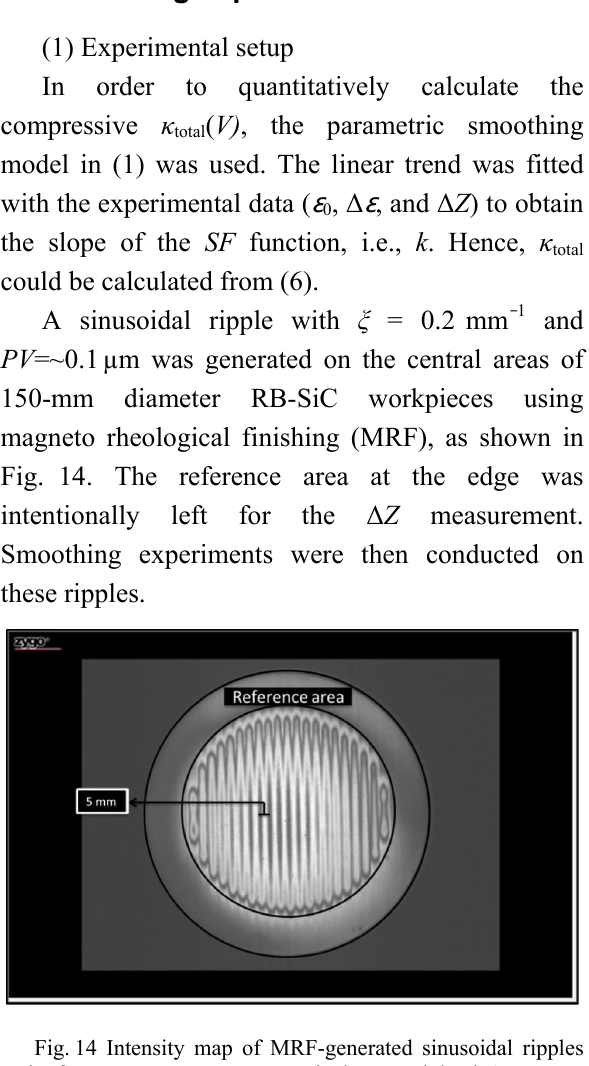
Fig. 14 Intensity map of MRF-generated sinusoidal ripples and reference area to measure nominal removal depth Δ Z .